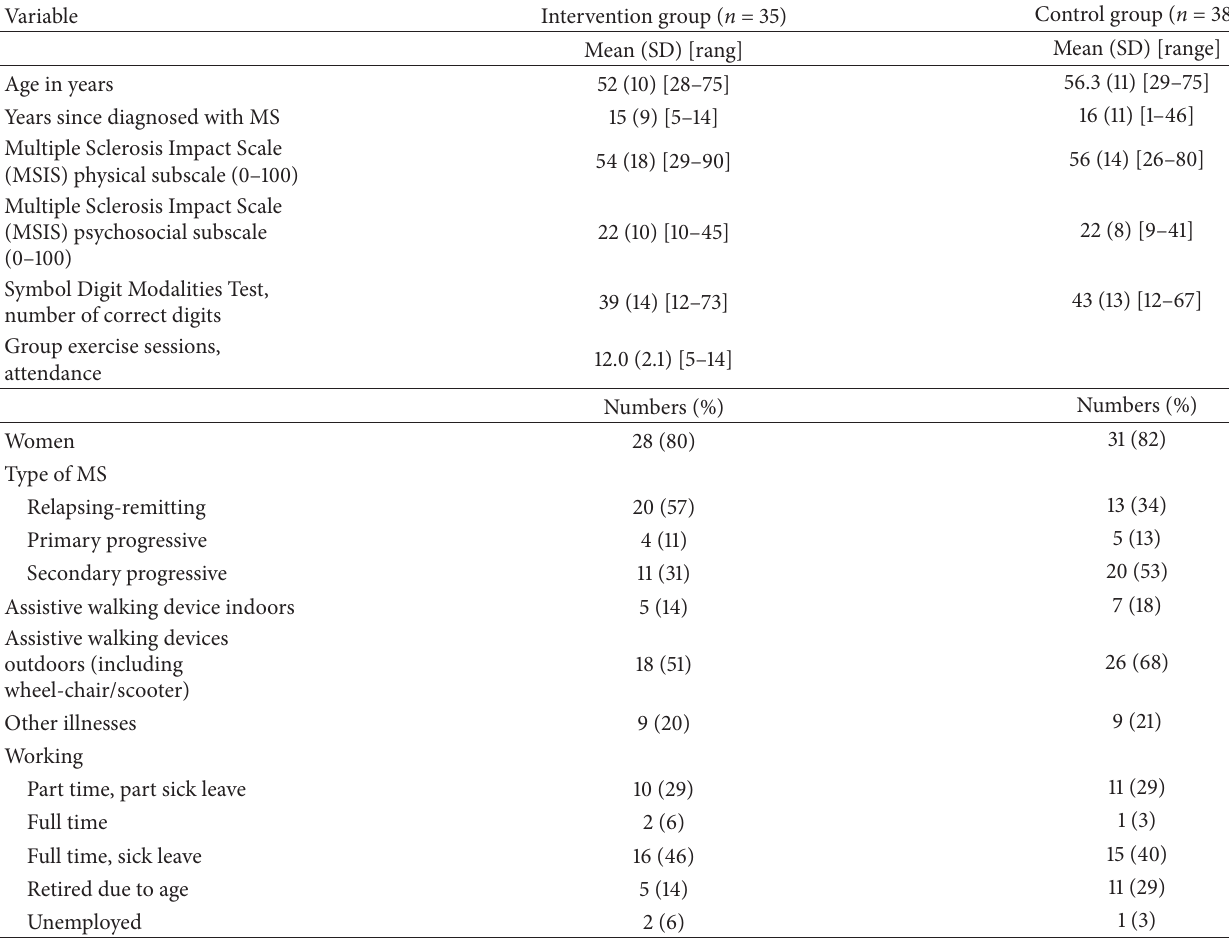
Table 1: Demographic and background